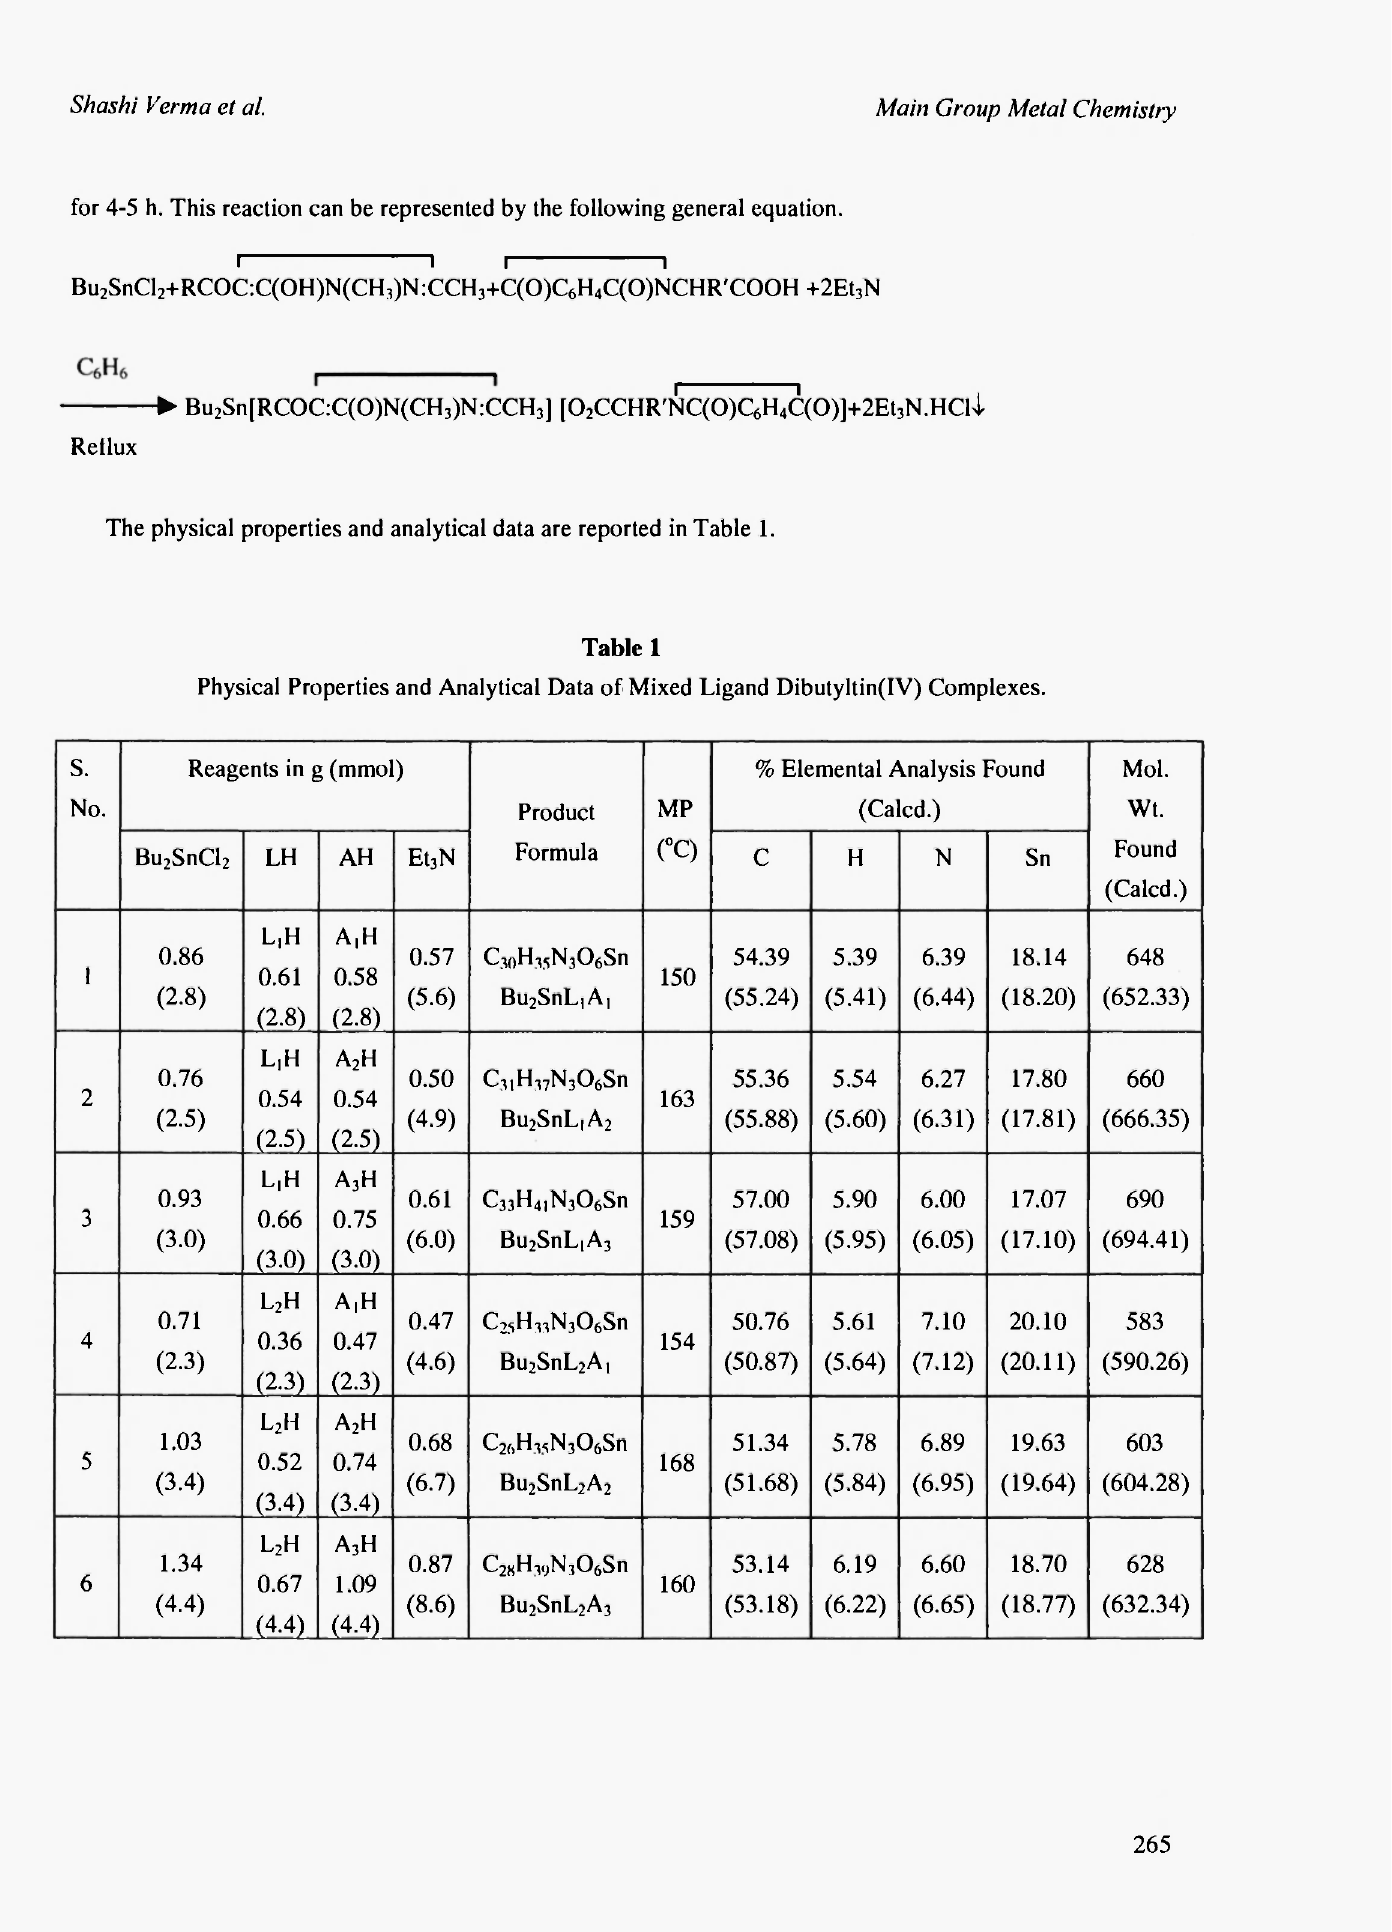
Physical Properties and Analytical Data of Mixed Ligand Dibutyltin(IV) Complexes.